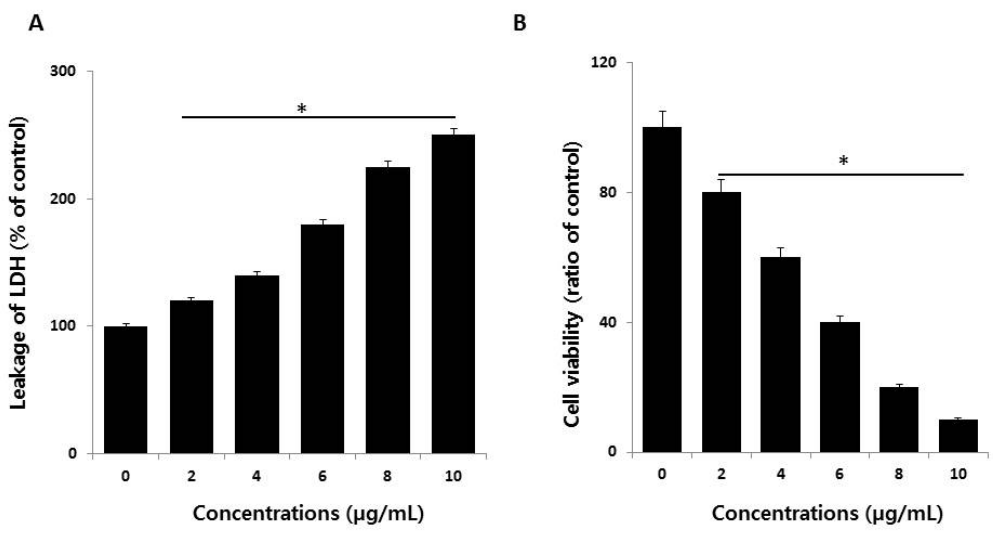
Figure 3. Measurement of lactate dehydrogenase (LDH) leakage and cell-death protease activity. ( A ) LDH activity was measured at 490 nm using an LDH cytotoxicity kit. ( B ) The level of dead-cell protease was determined using the CytoTox-Glo cytotoxicity assay. The results are expressed as the mean ± standard deviation of three independent experiments. There was a significant difference in the ratio for AgNP-treated cells compared to untreated cells, determined by a Student’s t -test (* p < 0.05).